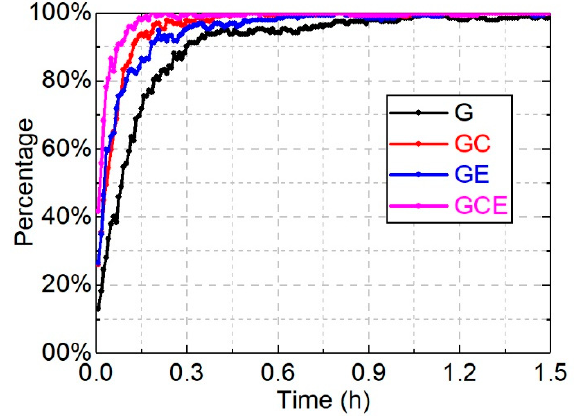
Figure 18. Ambiguity success fixing rate in the different solutions. Table 4. Ambiguity success fixing rate in the different solutions at different times.